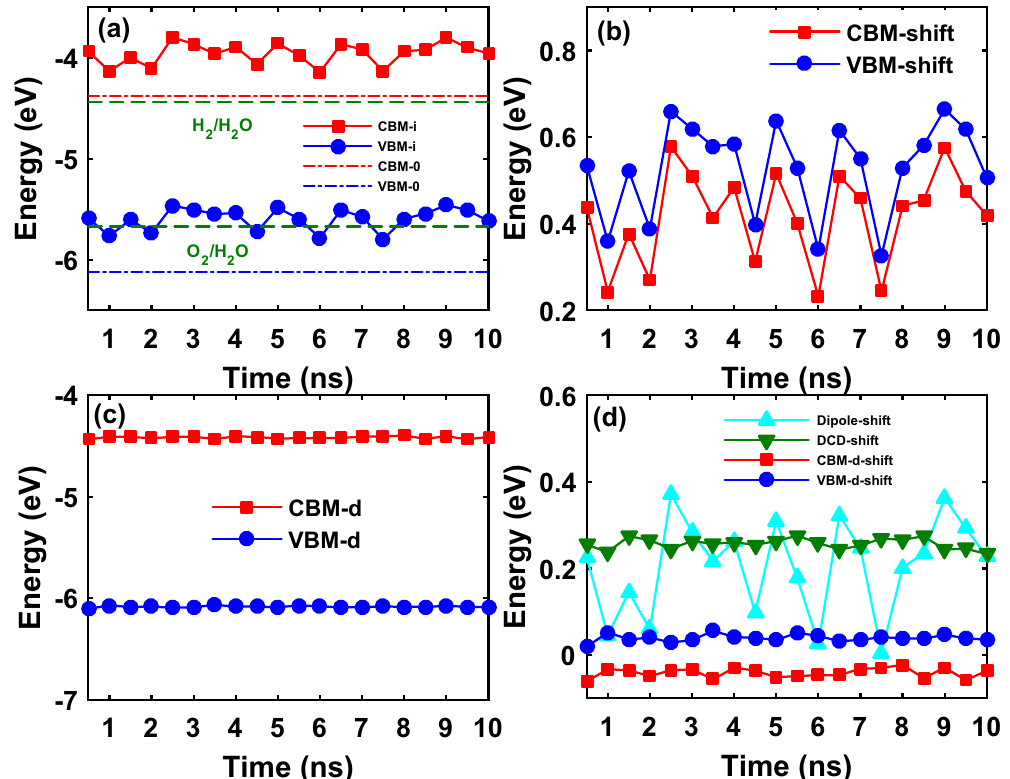
Fig. 2 Band edge shift of MoS 2 due to the presence of water. a The band edge of the combined MoS 2 /water system. The upper (lower) green dashed line is the water reduction (oxidation) potential energy level. Red (blue) dash dot line labeled as CBM-0 (VBM-0) is the CBM (VBM) of pristine MoS 2 (without water). Red square (blue circle) labeled as CBM-i (VBM-i) corresponds to the CBM (VBM) of the combined MoS 2 /water system. b The band edge shift of MoS 2 in the combined MoS 2 /water system compared with the pristine MoS 2 . CBM (VBM) shift is calculated by CBM-i (VBM-i) - CBM-0 (VBM-0). c The absolute position of band edge of distorted MoS 2 extracted from the combined system. CBM-d (VBM-d) represents the CBM (VBM) of distorted MoS 2 . d The shift values of band edge caused by three microscopic sources: water dipole effect, charge redistribution effect and geometric deformation effect. CBM-d-shift (VBM-d-shift) is the difference between the CBM (VBM) of distorted MoS 2 and pristine MoS 2